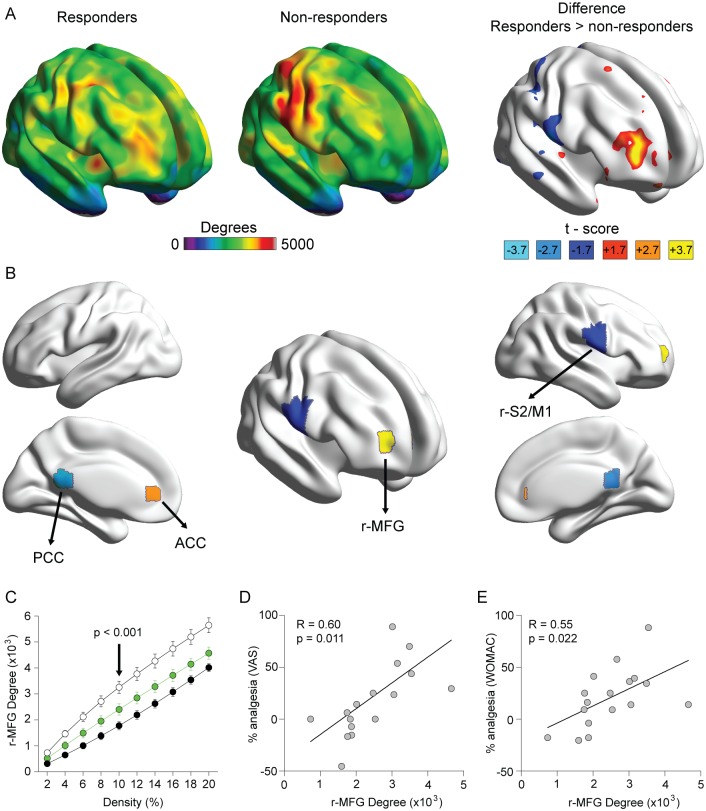
Patterns of brain connectivity in placebo responders and nonresponders in study 1.(A) Average brain maps for degree count (number of connections of any location to the rest of the brain), shown at 10% density in placebo responders (n = 8) and non-responders (n = 9), and the difference map. Placebo responders have higher (red to yellow colors) or lower (dark to light blue) degree counts than nonresponders. (B) The brain regions highlighted were identified based on minimal t-score and threshold-free cluster enhancement (TFCE) correction. The right midfrontal gyrus (r-MFG; x = 28, y = 52, z = 9 mm; cluster 12 voxels, t-score 3.7 or p < 0.001) was the region with the highest significant between-group difference, while bilateral anterior cingulate cortex (ACC; x = −3, y = 40, z = 2; cluster 10, t-scores 2.7 or p < 0.01), posterior cingulate cortex (PCC; x = −1, y = −45, z = 15; cluster 14, t-score −2.7 or p < 0.01), and a right region overlapping the secondary somatosensory and primary motor cortex (r-S2/M1; x = 60, y = −7, z = 21; cluster 31, t-score of 1.7 or p < 0.05) had lower significant differences. (C) Degree counts derived from r-MFG region in OA patients classified as placebo responders and nonresponders, and in healthy subjects (n = 20), for densities 2%–20%. At all densities, placebo responders (white) show higher degree counts than placebo nonresponders (black, group * density F9,135 = 15.3, p < 0.0001) or healthy controls (green, F9,234 = 5.8, p < 0.0001). (D, E) r-MFG degree counts at 10% density significantly predicted future (2-wk) magnitude of % analgesia for all OA patients based on both VAS and WOMAC scores. In C–E; black, gray, and white symbols represent the same groups as in Fig 1, while green symbols represent the healthy controls on which brain imaging was performed.